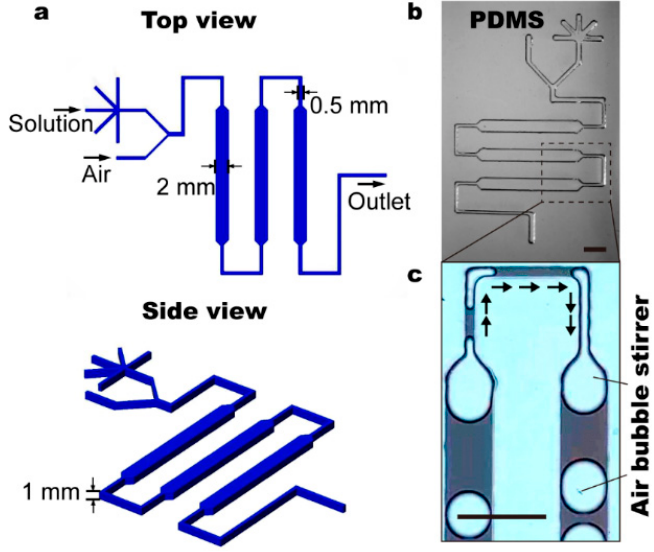
Figure 1. Schematic drawing ( a ) and optical image ( b ) of the fluidic mixer. ( c ) Air bubbles generated on-chip and transport within fluidic channels. Scale bars denote 4 mm in all figures.